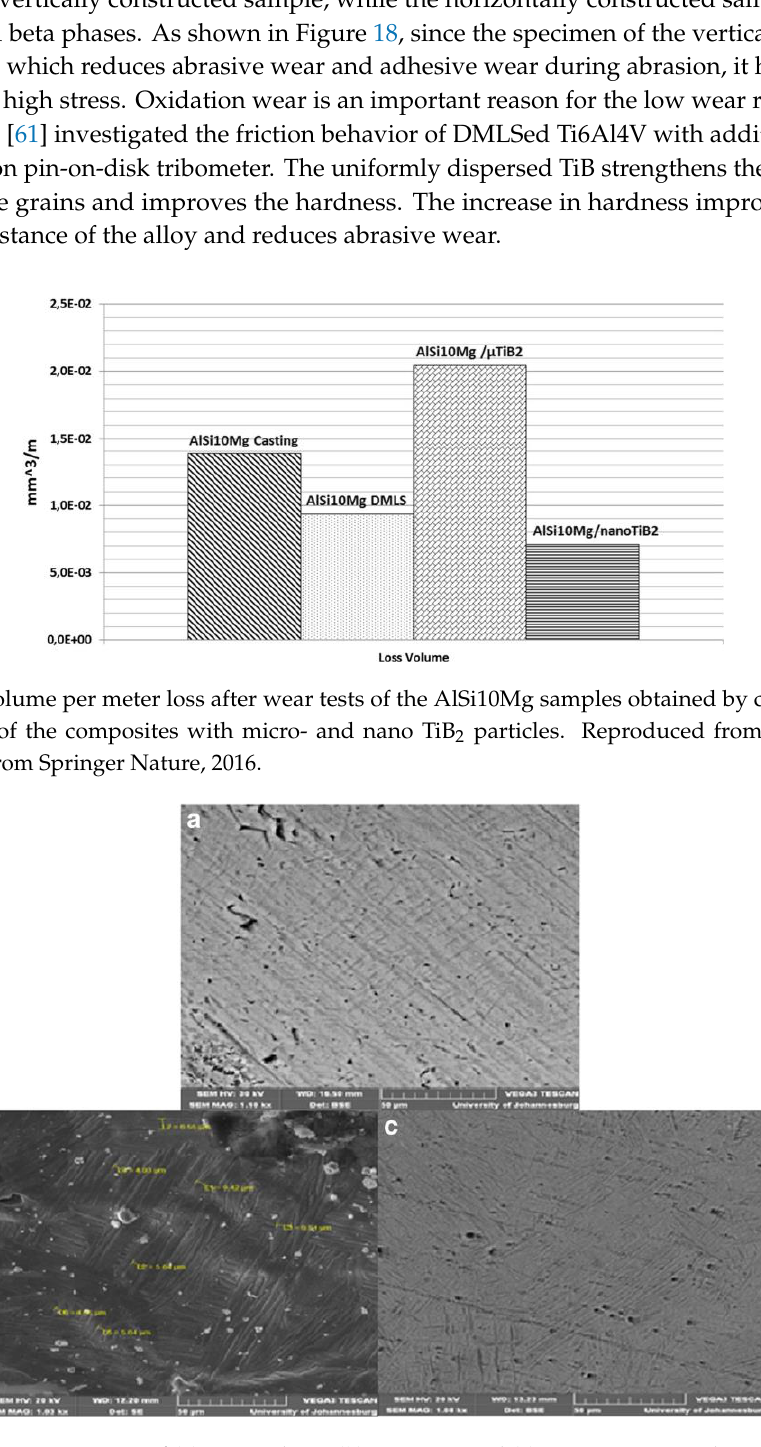
Figure 17. Wear volume of assintered and heat-treated specimens. Reproduced from [58], with permission from Springer Nature, 2017.